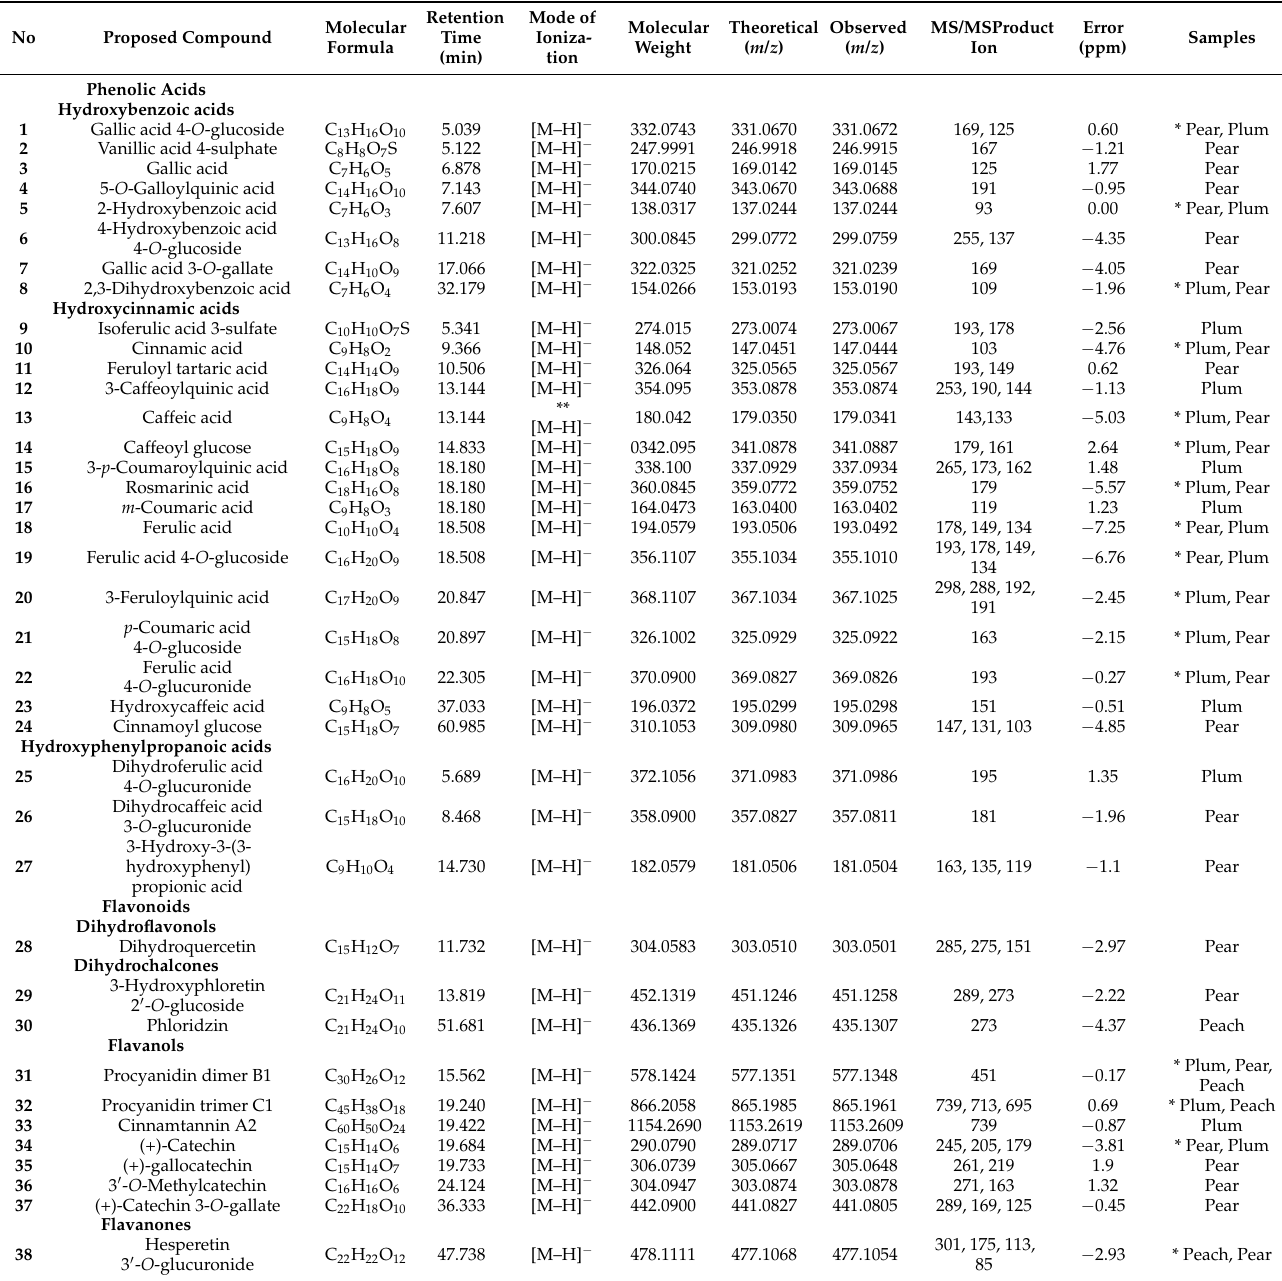
Table 2. Retention time, mass-to-charge ratio, and characteristic precursor and product ions found for polyphenolic compounds identified in peaches, pears, and plums using LC-ESI-QTOF-MS/MS